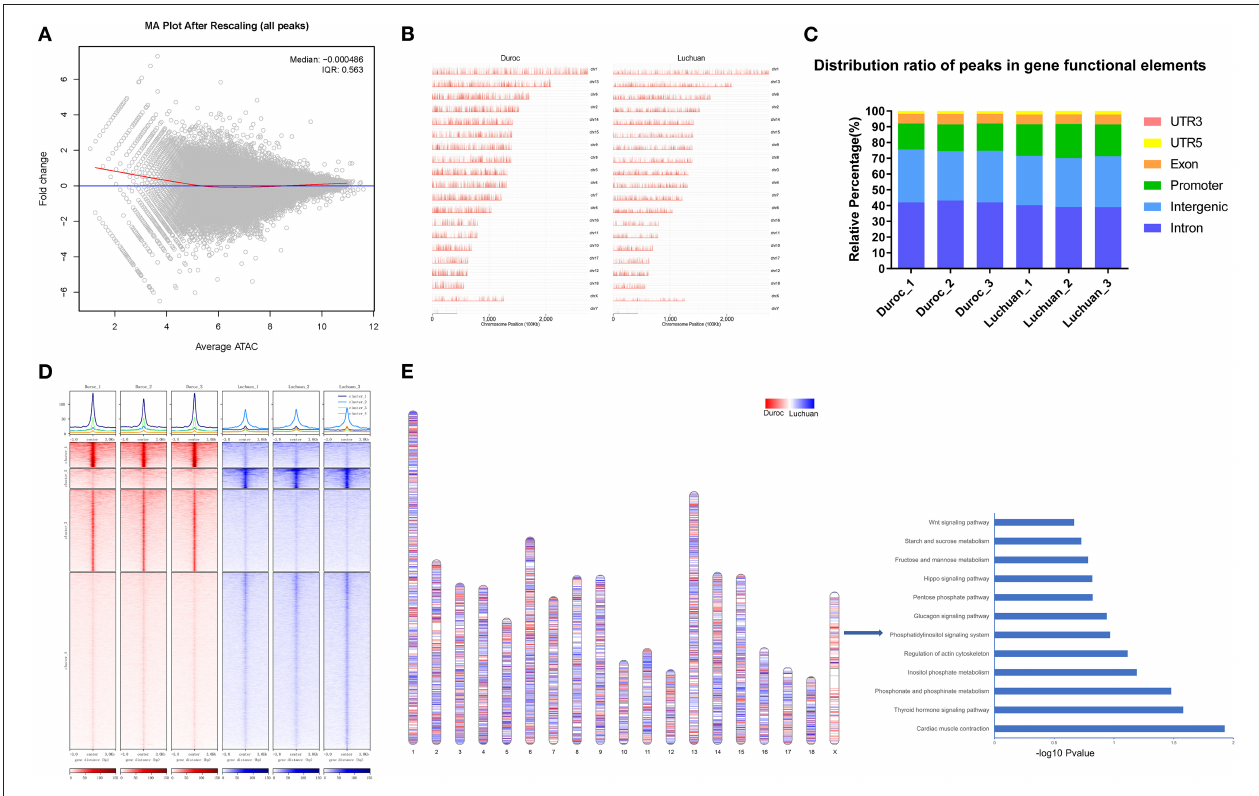
FIGURE 2 | Analyses of the peaks. (A) MA plot. The x -axis represents signal strength in the open region of chromatin, and the y -axis represents fold change. (B) Chromosomal distribution of all peaks. (C) Distribution ratio of peaks in gene functional elements. (D) Top, enrichment of ATAC-seq signals around the 3kb upper and lower reaches of the peak center. Bottom, peaks are divided into four categories according to the signal intensity. (E) Left, chromosome distribution of Duroc peaks and Luchuan peaks ( P < 0.01). Right, KEGG pathway enrichment analysis of the genes corresponding to Duroc peaks on the X